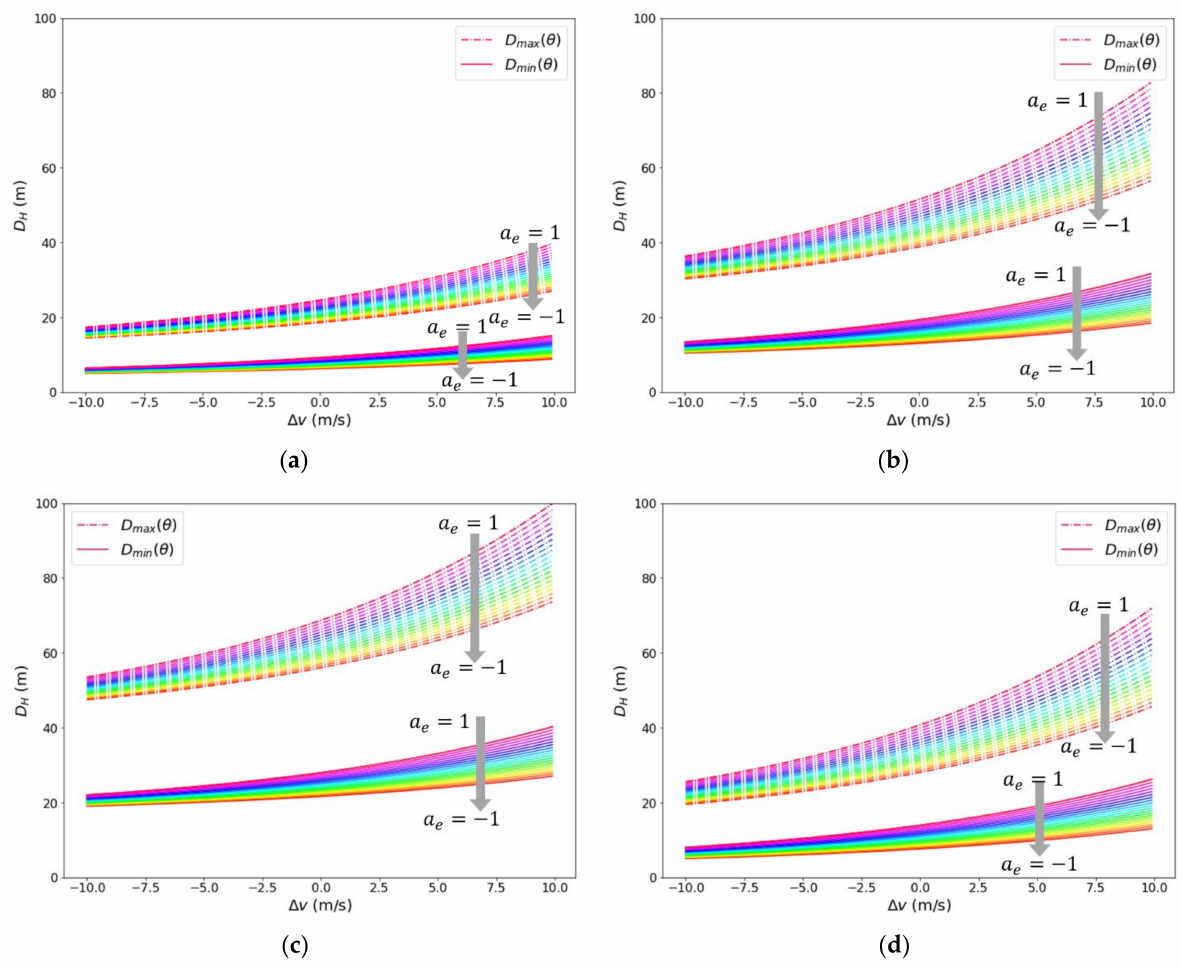
Figure 8. Critical distances D max and D min in a side crash: ( a ) v f = 10 m/s, a f = 0 m/s 2 , θ = 5 ◦ ; ( b ) v f = 20 m/s, a f = 0 m/s 2 , θ = 5 ◦ ; ( c ) v f = 20 m/s, a f = − 2 m/s 2 , θ = 5 ◦ ; ( d ) v f = 20 m/s, a f = 2 m/s 2 , θ = 5 ◦ .